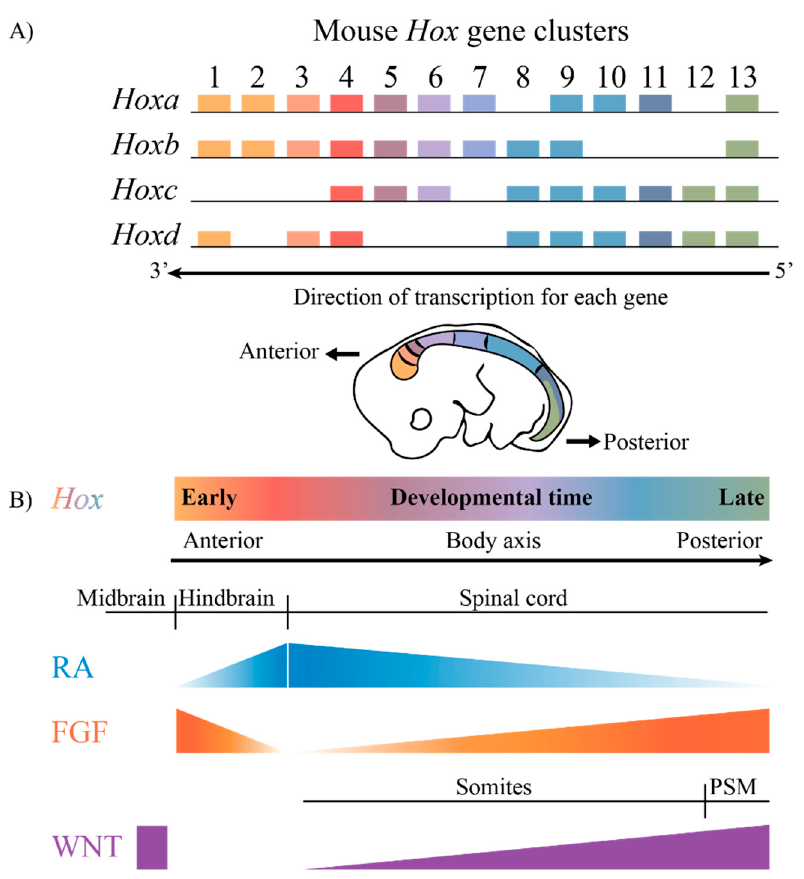
Figure 1. The mammalian Hox gene clusters and the conserved signaling pathways that play a role in defining the Hox gene expression profiles. ( A ) In mammals, there are four clusters of Hox genes, each on different chromosomes. They exhibit spatial and temporal collinearity, such that 3 ′ Hox genes are expressed early in development as well as more anteriorly in an embryo generating nested domains of expression as depicted in the drawing of an E10 mouse embryo. ( B ) The restricted domains of Hox expression arise through an integration of signaling molecules such as RA, FGF and WNT, which are expressed in gradients along the embryonic axis. PSM, presomitic mesoderm.